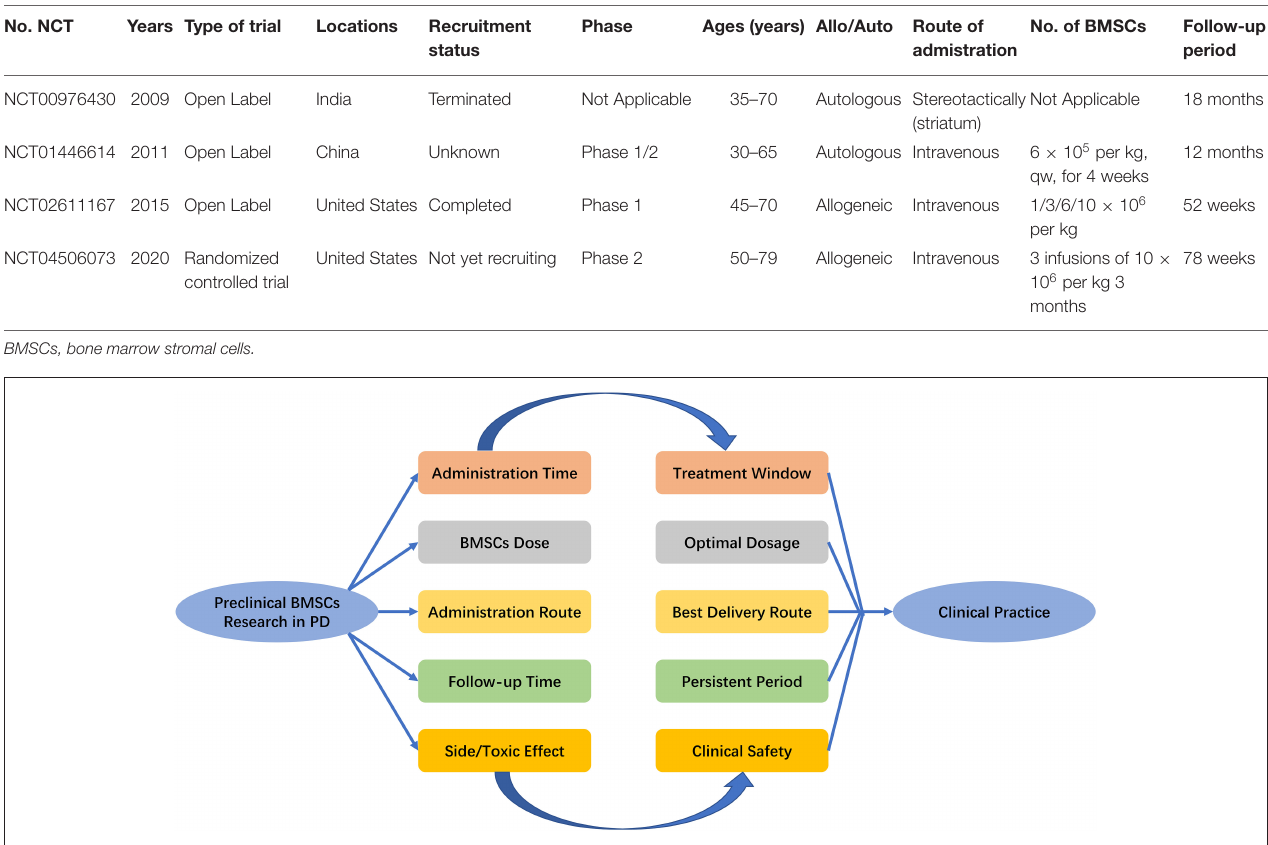
TABLE 3 | Clinical trials using BMSCs in PD that are registered with ClincalTrials.gov (as of October 2020). No. NCT Phase Ages (years) Allo/Auto Route of